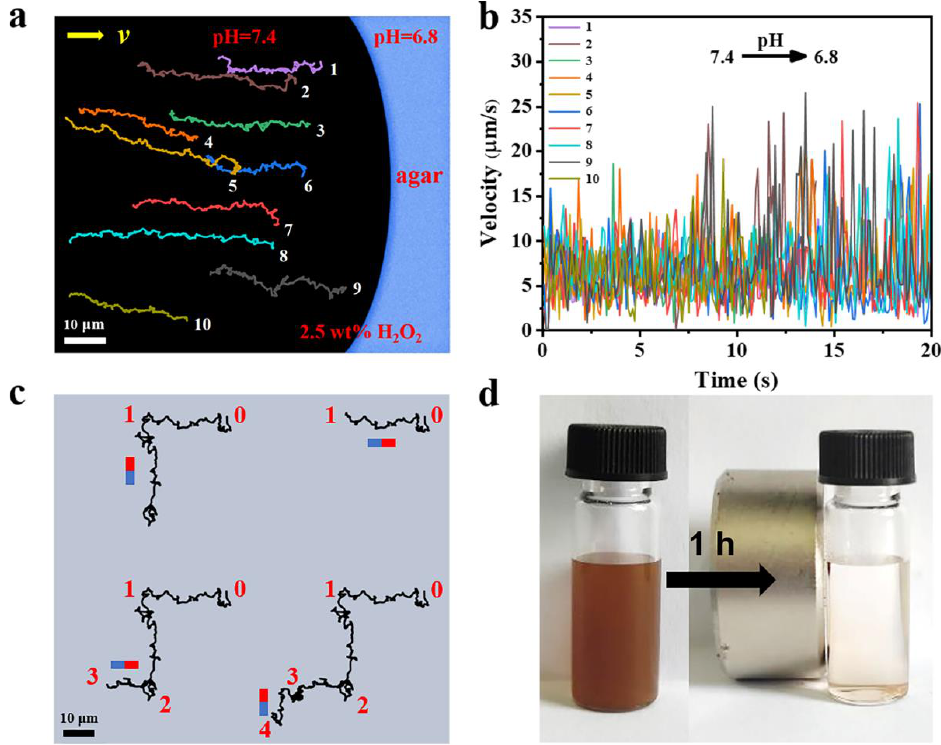
Figure 6. Chemotactic motion of the as-prepared FCNMs from pH 7.4 to 6.8 and magnetic responsiveness of the FCNMs. ( a ) The chemotactic track trajectories of the FCNMs in two pH environments in 30 s. ( b ) Real-time velocities for different FCNMs in 20 s. ( c ) Motion trajectories of a typical FCNM in 2.5 wt% H 2 O 2 aqueous solution at pH 6.8 under magnetic manipulation. ( d ) Photograph of the FCNMs dispersed in aqueous solution and their magnetic separation for about 1 h.